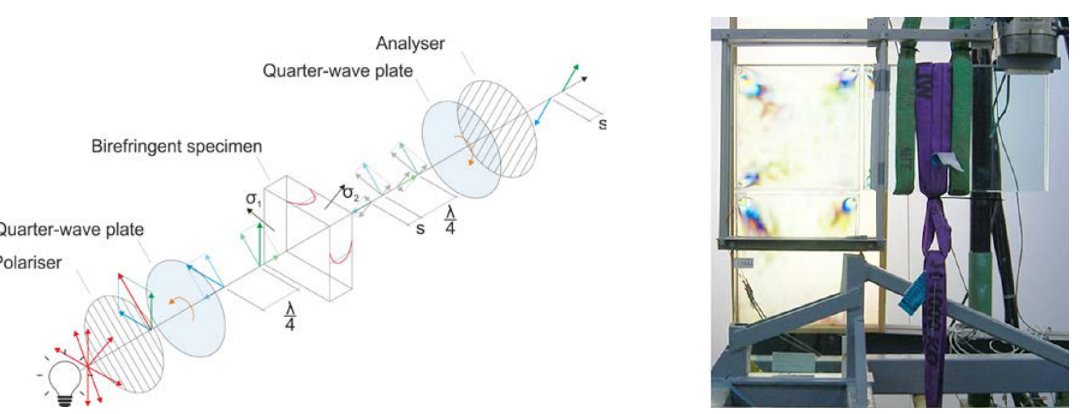
Fig. 5 Schematic setup of circular polariscope (left, Schaaf 2017), Polarising filter image of a bonded column beam connection (right, Prautzsch